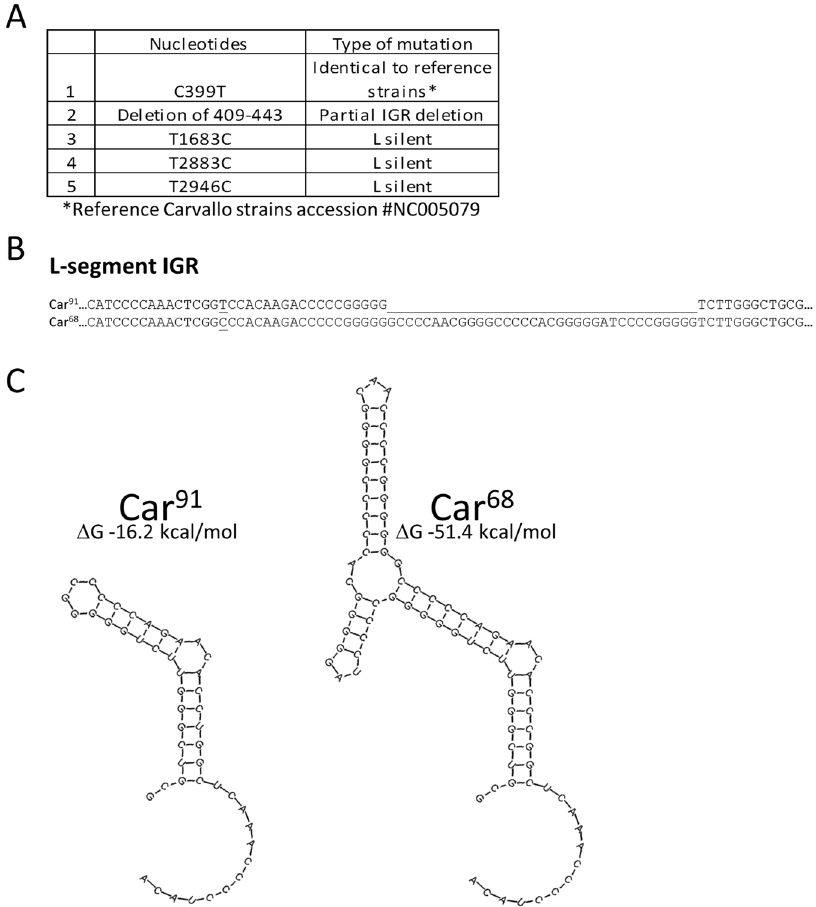
Figure 3. Sequence of MACV strain Car 91 and Car 68 . ( A ) Predicted L-segment amino acid changes between Car 91 and Car 68 . ( B ) Alignment of the Car 91 and Car 68 IGR. The underlined region denotes the region deleted in Car 91 . Also underlined is the single nucleotide change at position 399. ( C ) Predicted hairpin tertiary structure of the Car 91 and Car 68 L-segment